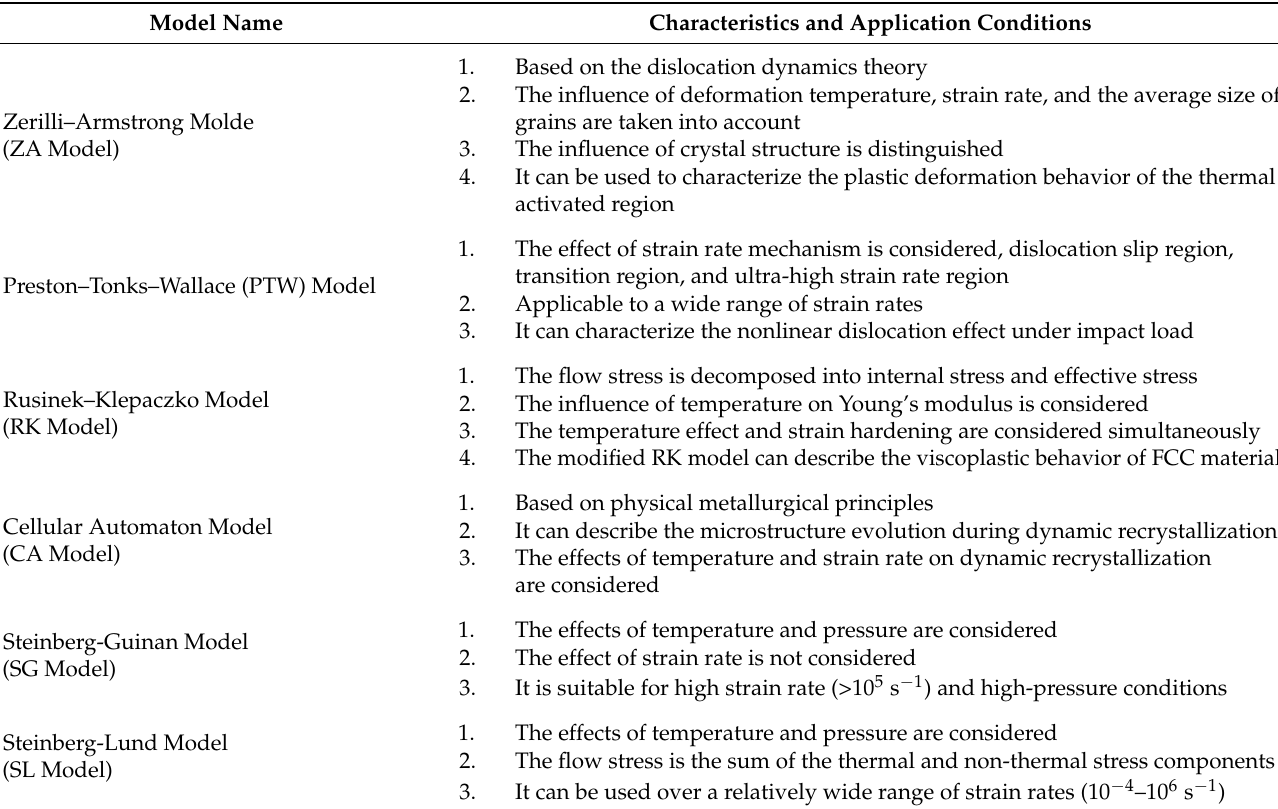
Table 2. The characteristics of microscopic constitutive